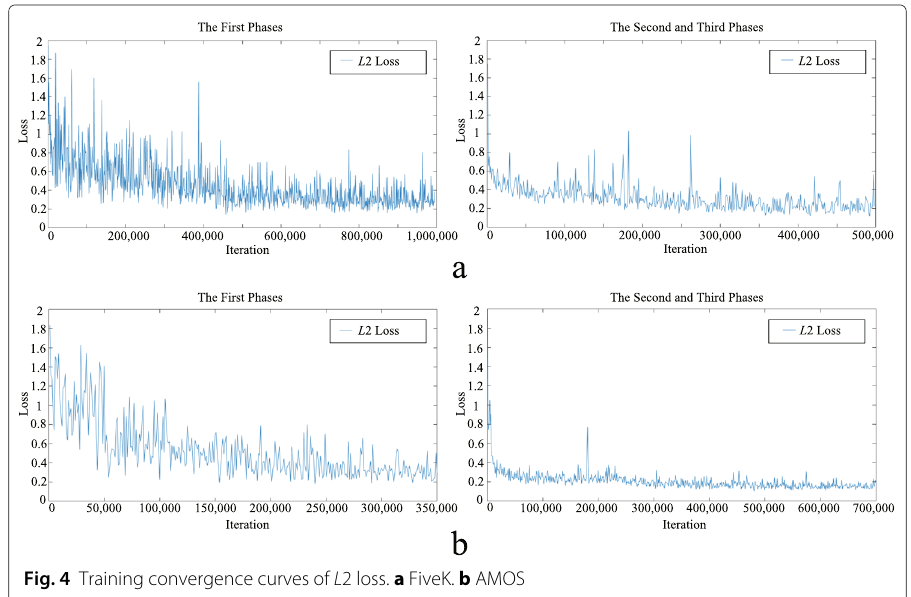
Fig. 4 Training convergence curves of L 2 loss. a FiveK. b AMOS